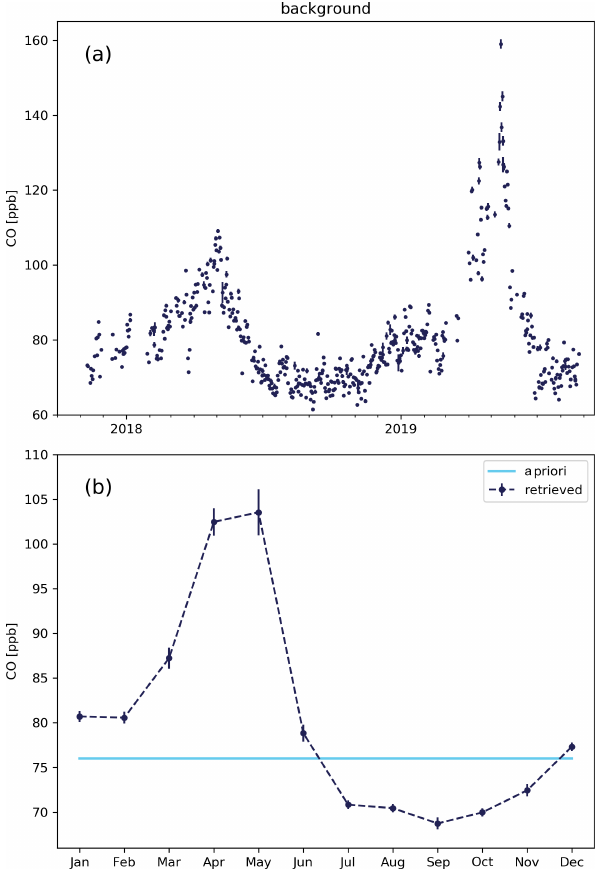
Figure 2. Background CO concentration for the domain shown in Fig. 1 estimated by fitting the WRF-Chem simulation to the TROPOMI data. (a) Background CO for individual collocations from 9 November 2017 to 25 August 2019. (b) Monthly mean back- ground CO based on the individual collocations. The error bars are the standard error in the mean, and the light-blue line is the time- invariant a priori used in the